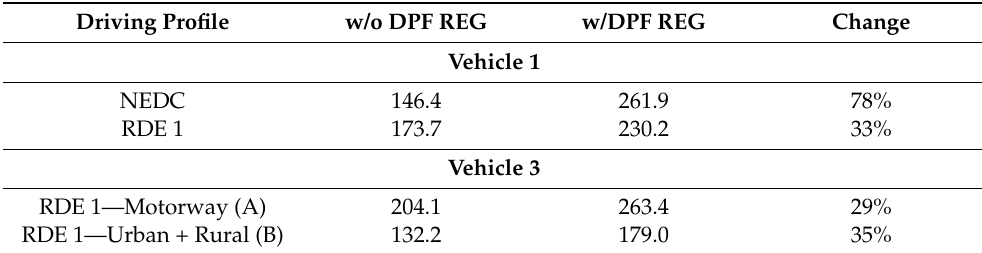
Table 5. CO 2 emissions [g/km] during DPF regeneration under different operating conditions.